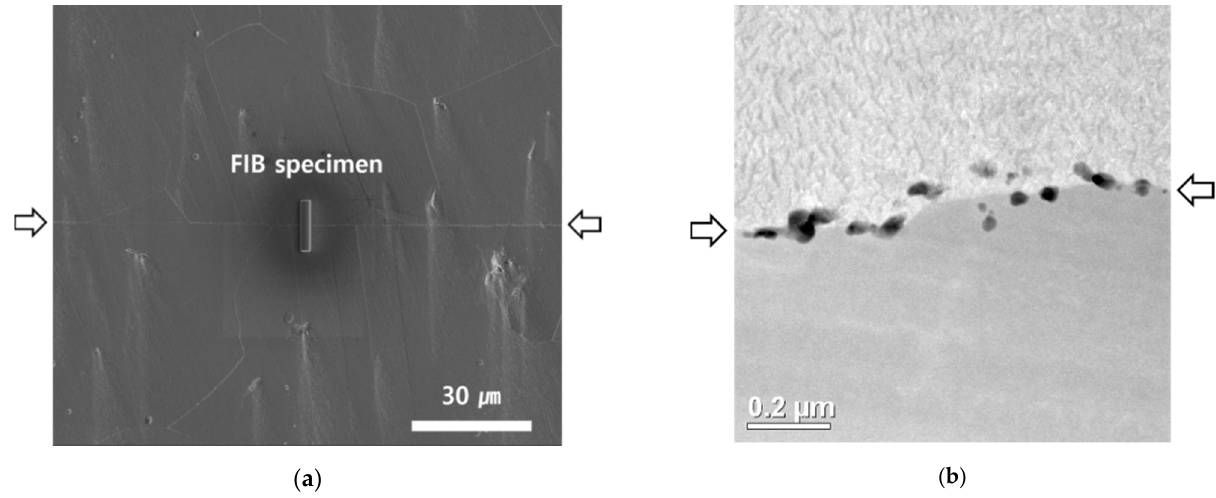
Figure 3. Electron microscopy analysis of the diffusion-welded Alloy 617 near the interface: ( a ) SEM and ( b ) TEM. The arrows indicate the interface of the diffusion weldment. ( a ) shows the location for FIB specimen extraction.